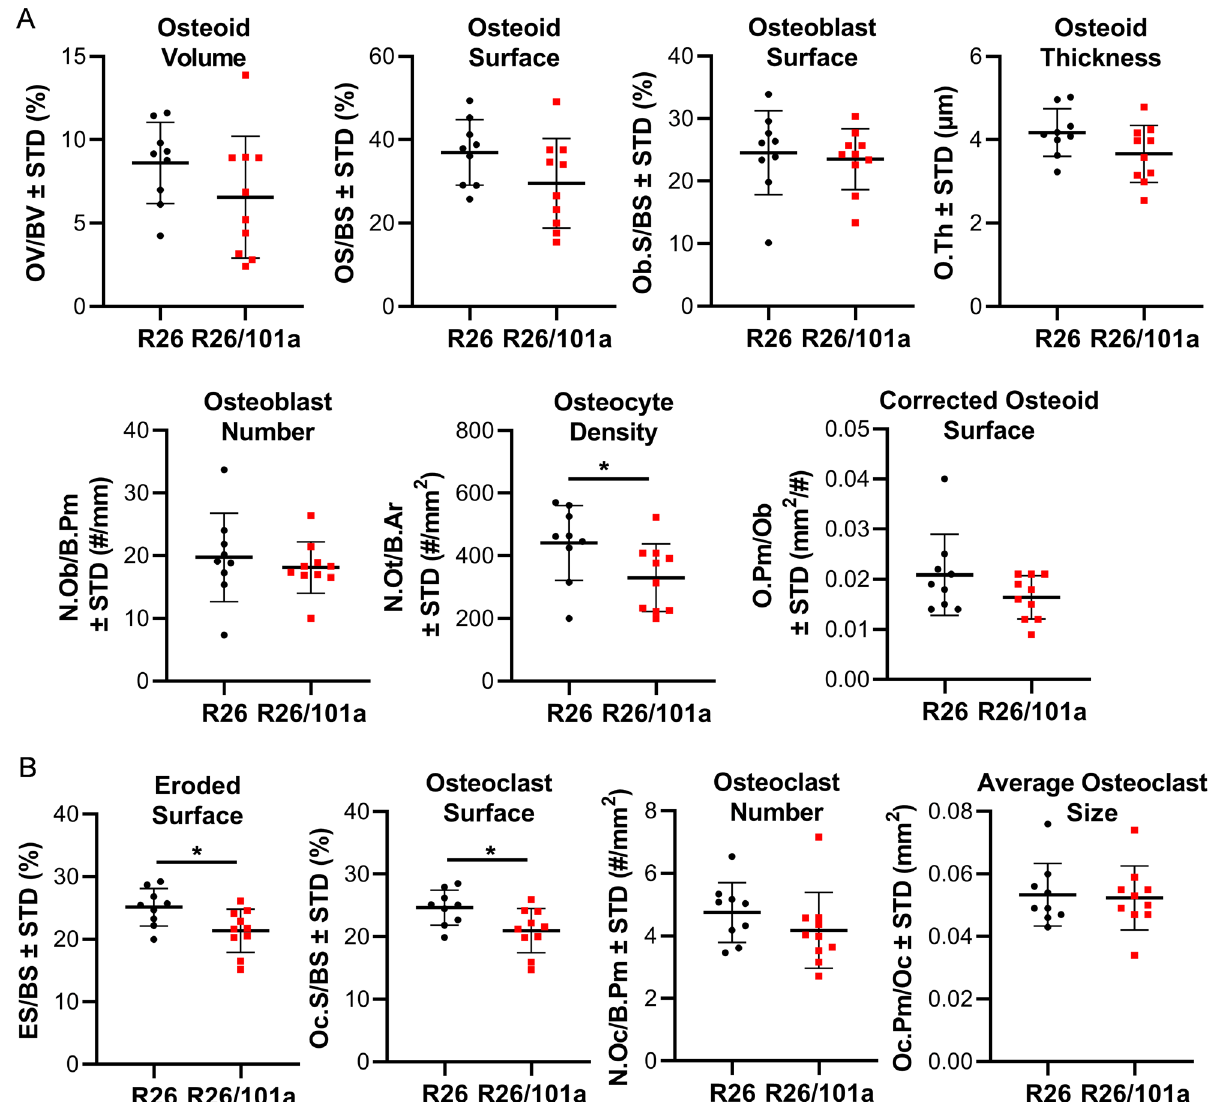
Figure 9. Histomorphometric alterations upon miR-101a over-expression in female mice. Femora (right) were collected from R26 control and miR-101a over-expressing (R26/101a) female mice treated with doxycycline from inception to sacrifice (8 weeks). The figure depicts histomorphometry measurements of von Kossa/ McNeal-stained ( A ) and TRAPase/Toluidine blue-stained ( B ) sections derived from of sagittal femora slices (n = 9 to 10, mean ± STD). *p <